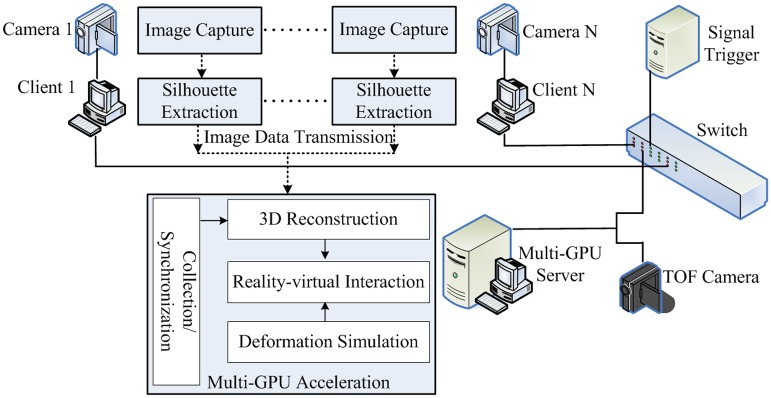
System architecture.